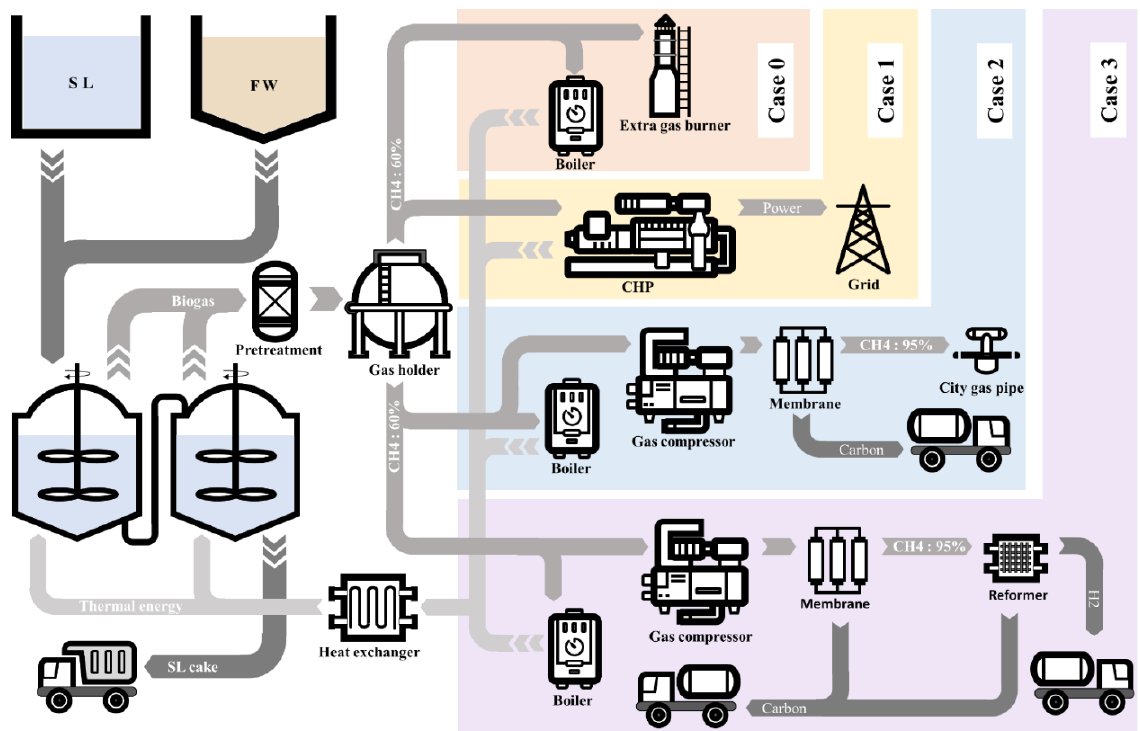
Figure 5. Proposed system configuration diagram.